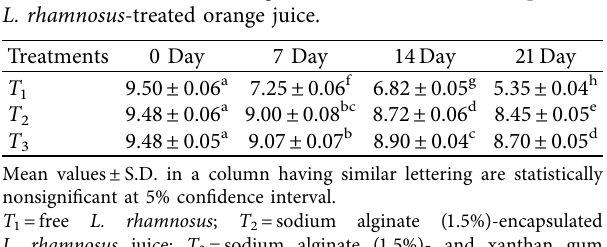
Table 4: Probiotic count (log CFU/mL) of free and